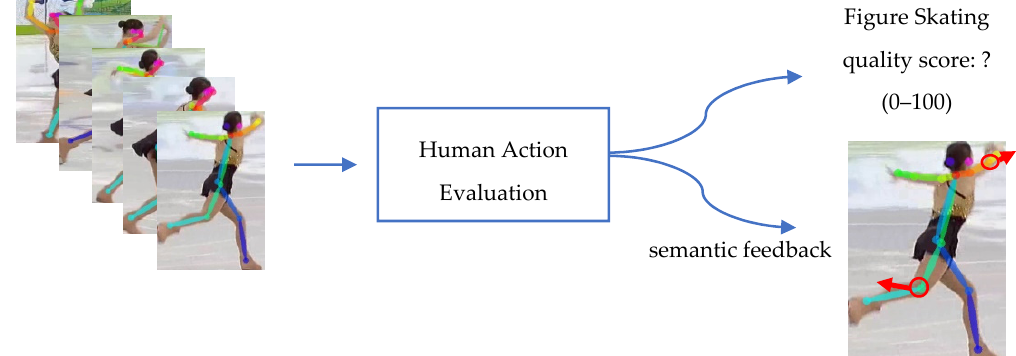
Figure 3. The task of human action evaluation (not only identifying action labels but also assessing the quality score and providing semantic feedback).